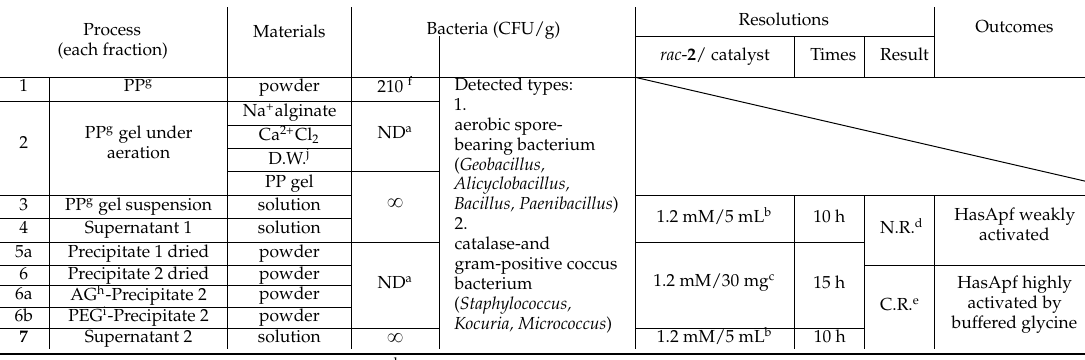
Table 1. Relation of the amount of bacteria to the kinetic resolutions of rac - 2 for each fraction. Process (each